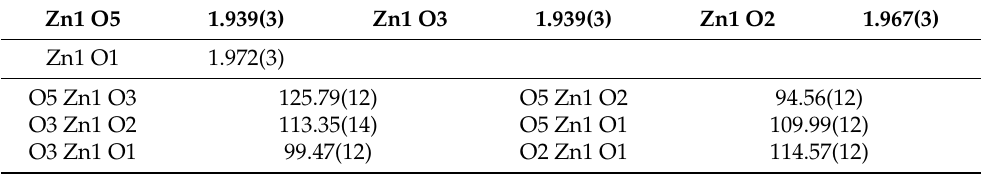
Table 2. Selected bond lengths(Å) and angles( ◦ ) for MOF Zn(BTC) 4 .